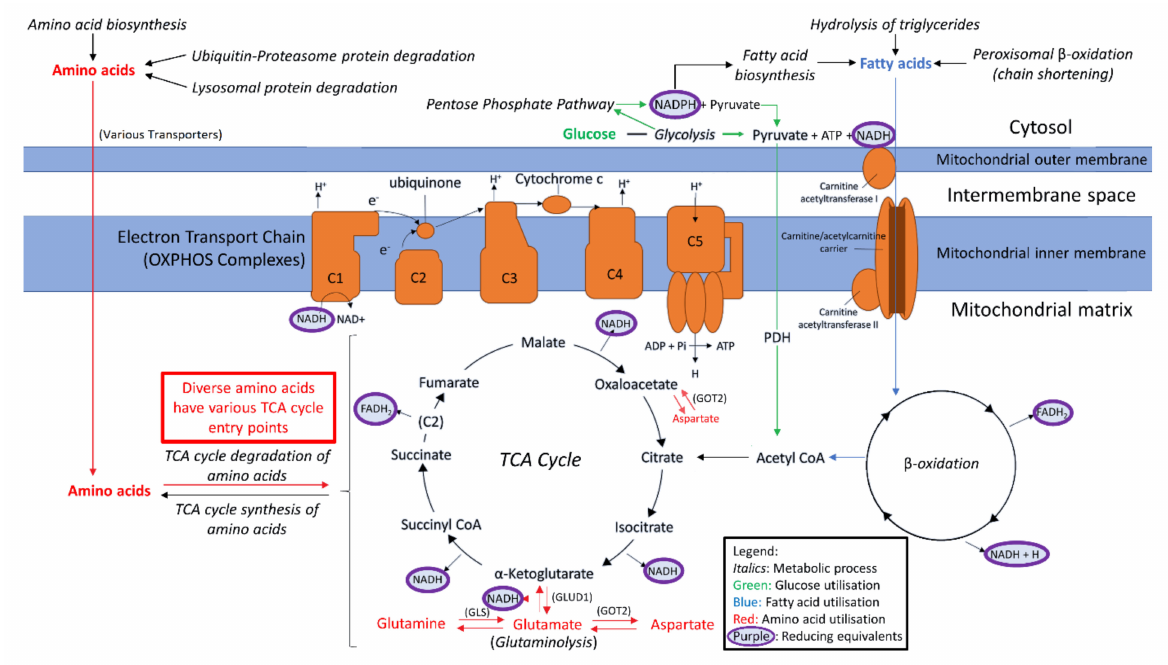
Figure 1. Simplified depiction of oxidisable substrate provision and usage by the mitochondria. The generalised “flow” of substrate molecules derived from glucose, fatty acids or amino acids is represented by arrows colour-coded green, blue and red, respectively. Reducing equivalents are denoted by purple. Processes are italicised. Glucose may be catabolised by glycolysis in order to provision the mitochondria with pyruvate, converted by pyruvate dehydrogenase (PDH) to acetyl CoA for entry into the TCA cycle. Fatty acid β -oxidation also provides acetyl CoA for the TCA cycle, by the catabolism of lipids rather than carbohydrates. The means by which amino acids may be similarly utilised are diverse and are described as appropriate throughout the text. However, we have highlighted glutamine usage in this figure due to its importance. Glutamine may be converted to glutamate by glutaminase. Glutamate may be converted to α -KG by glutamate dehydrogenase (GLUD1) for entry into the TCA cycle, or to aspartate by mitochondrial aspartate aminotransferase (GOT2) which is utilised in cellular redox balancing and TCA cycle anaplerosis, thereby providing both reducing equivalents for OXPHOS and intermediates for the TCA cycle. Reducing equivalents resultant from these myriad processes can deposit electrons into the electron transport chain to facilitate generation of the proton-motive force which drives ATP